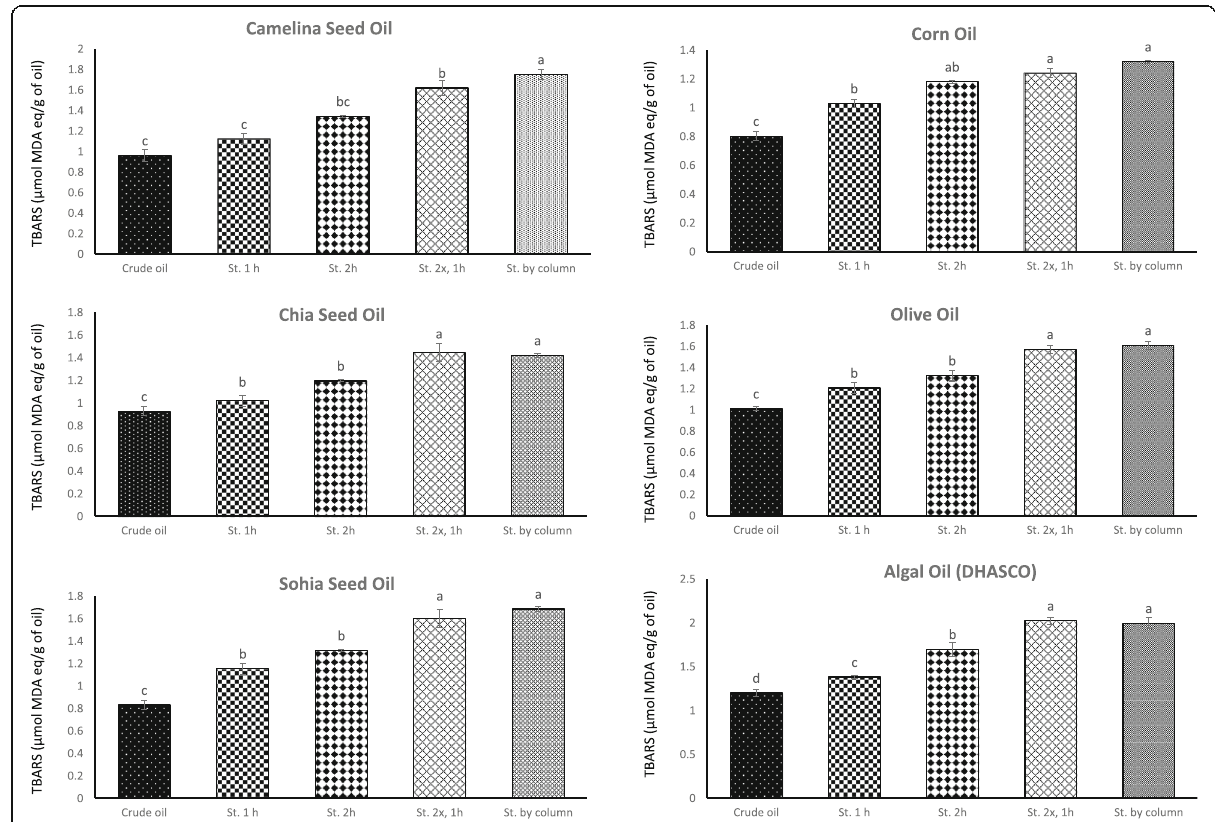
Fig. 3 TBARS (MDA equiv.) of stripped and non-stripped camelina seed oil, sophis seed oil, chia seed oil, corn oil, olive oil, and